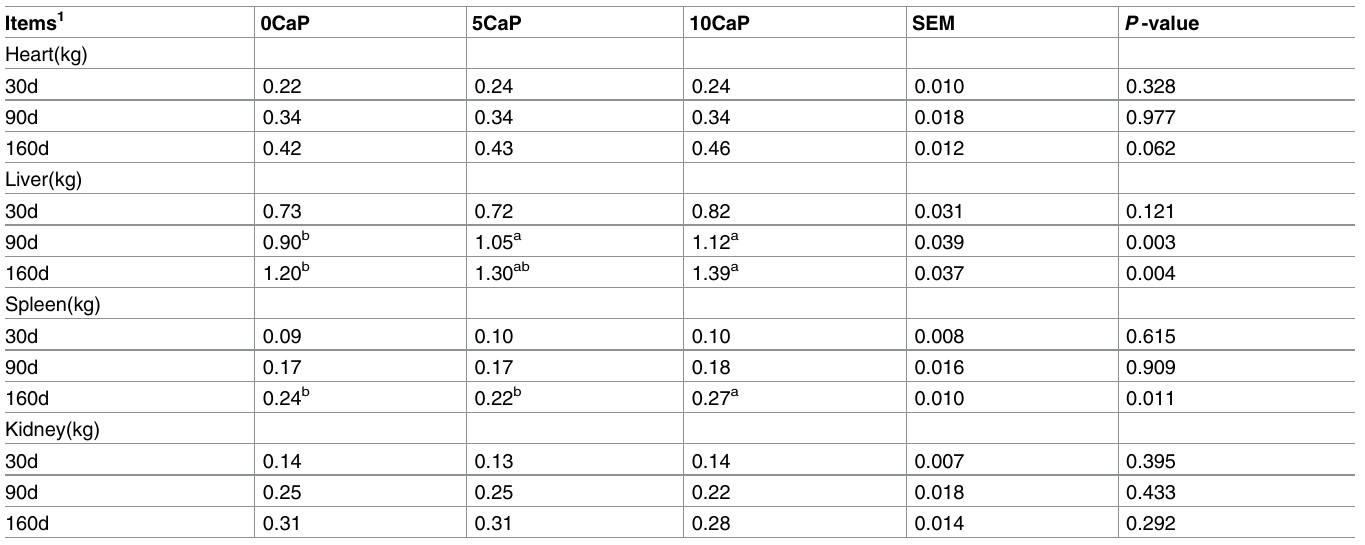
Table 3. The internal organs development of calves supplemented with calcium propionate at various stages of growth